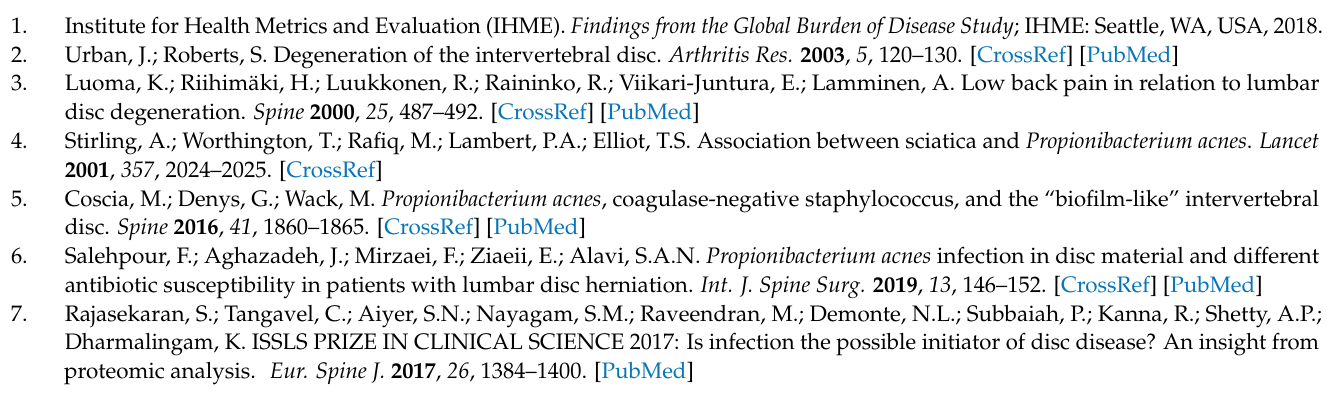
spine injection technique. Figure S2: 25 gauge needles within the 20 gauge introducer needles, serially spaced, extending into the lumbar